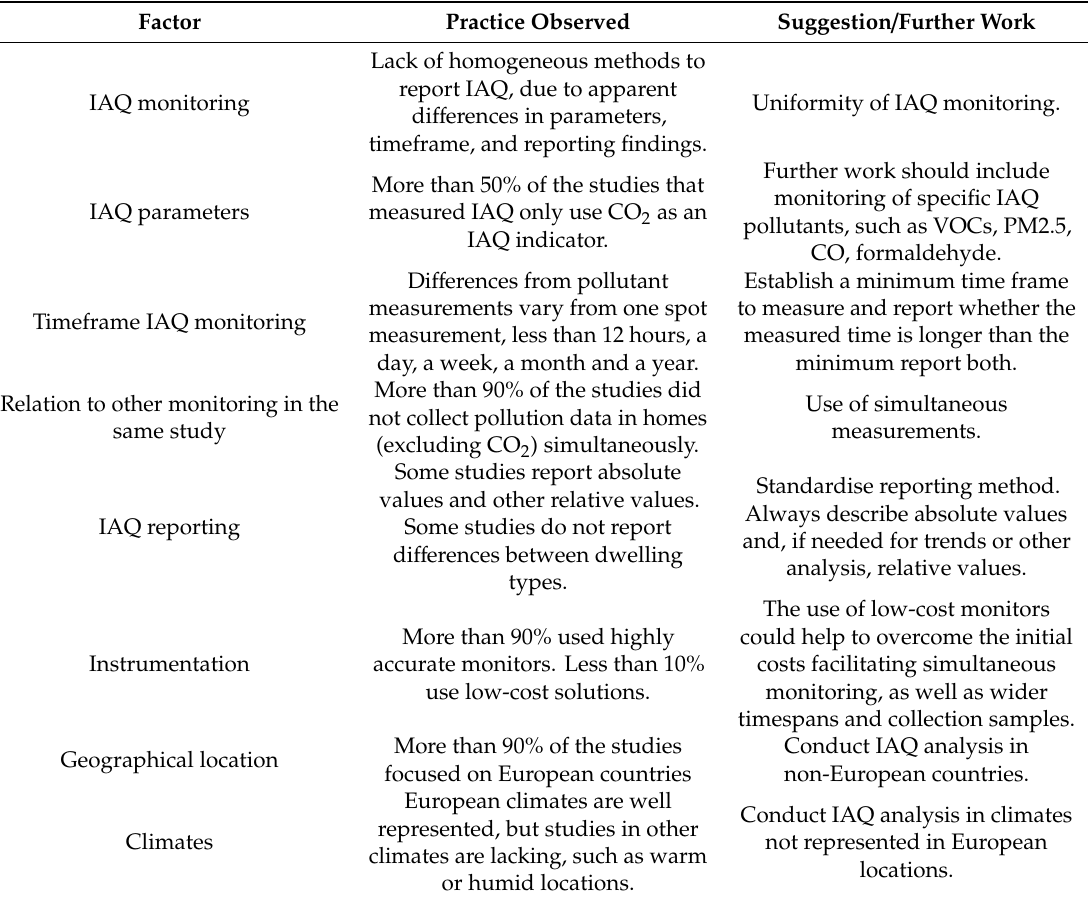
Table 4. Summary of main